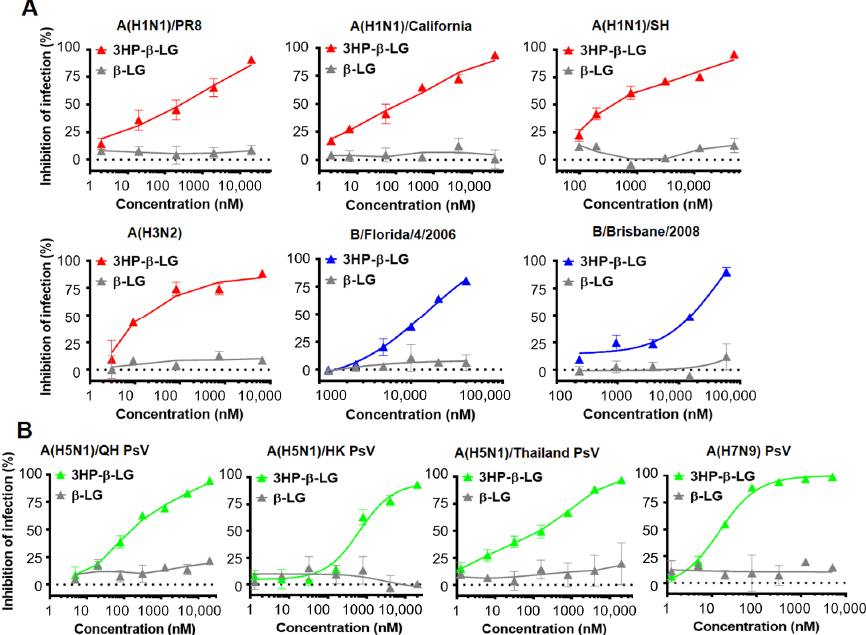
Figure 1. Inhibition of 3HP- β -LG against diverse influenza viruses. ( A ) Inhibition of authentic influenza viruses was detected by plaque reduction assay. ( B ) Inhibition of influenza A (H5N1) PsV infection was detected by luciferase assay. Samples were tested in triplicate and the data are